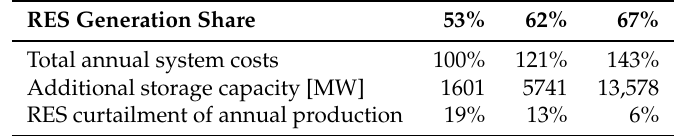
Table 2. Impact of different renewable energy generation shares to significant parameters.